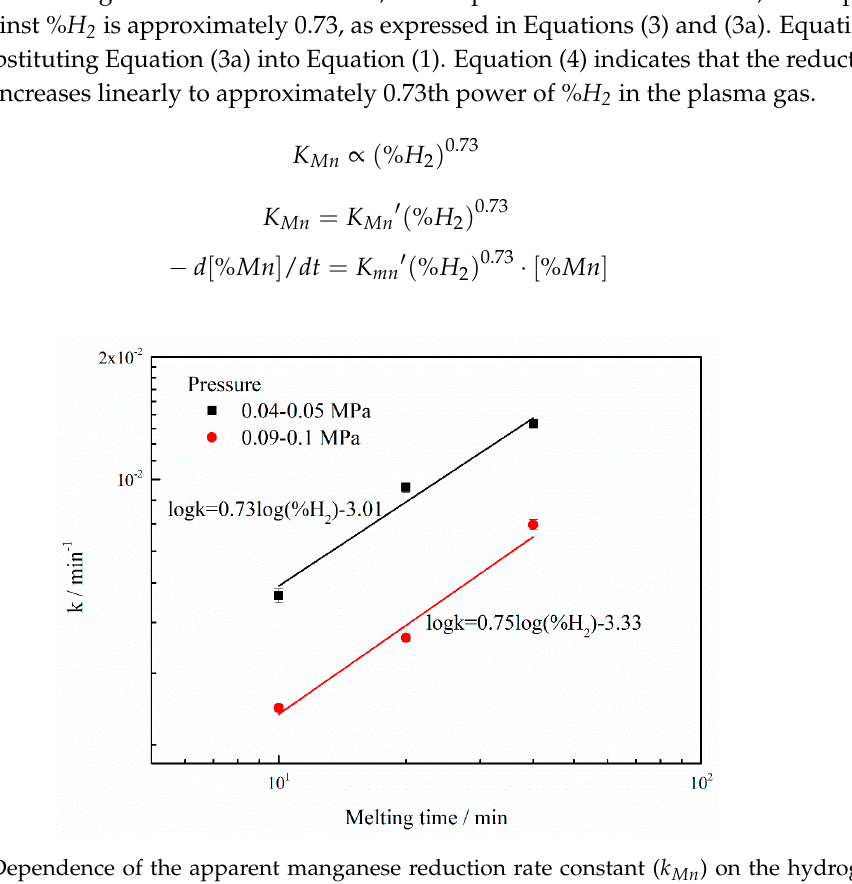
Table 1 The manganese reduction rate constant and its corresponding standard error.